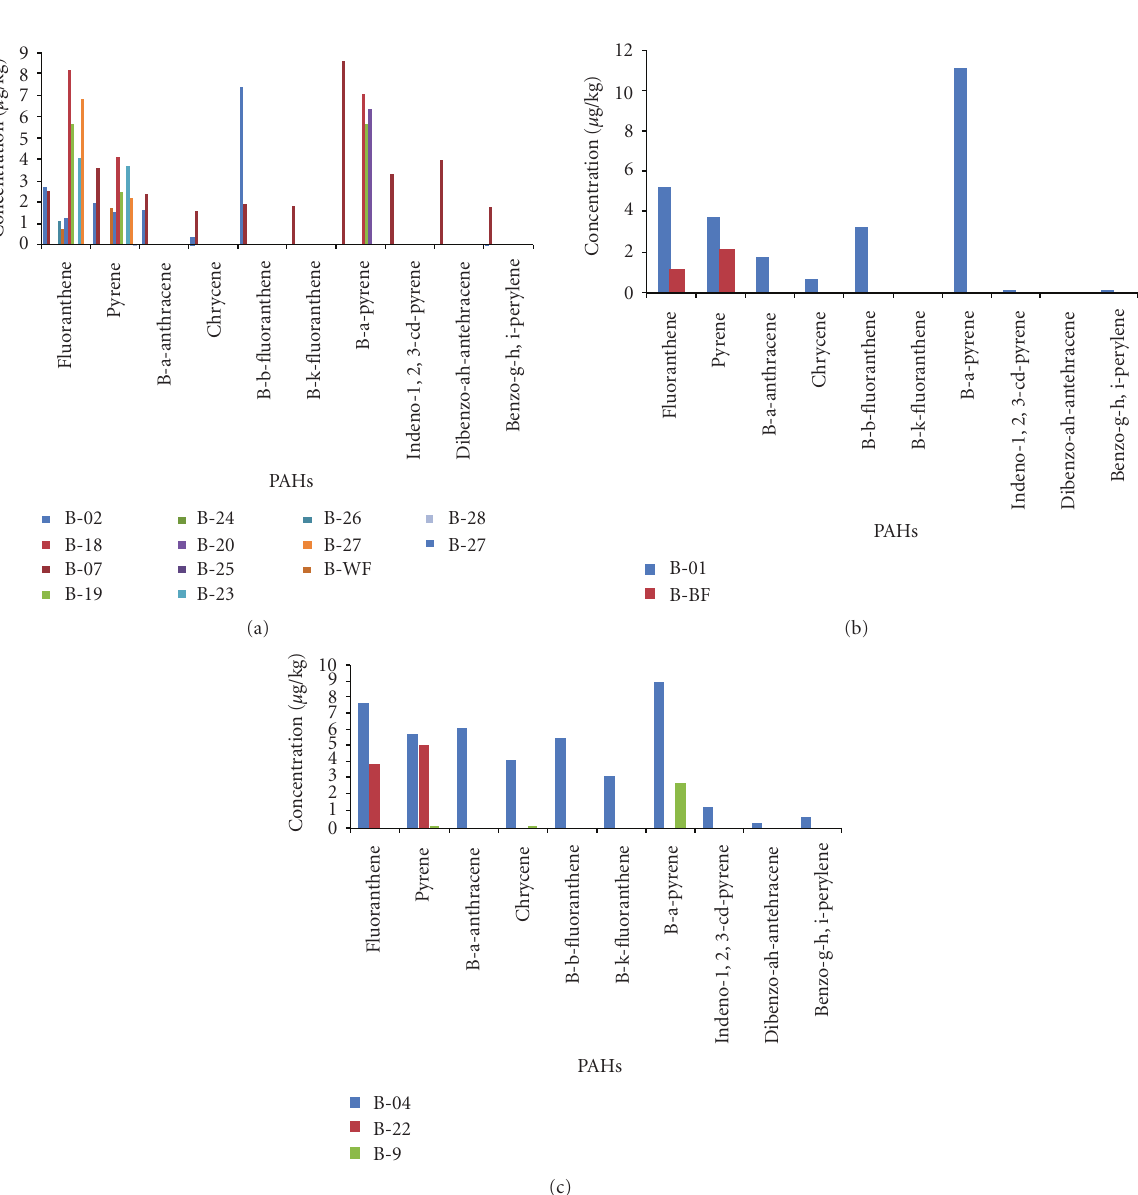
Figure 2: (a) Concentrations of PAHs obtained from bread samples baked with white Wheat flour (b) Concentrations of PAHs obtained from bread samples baked with Brown Wheat flour (c) Concentration of PAHs obtained from sandwich bread sample baked with white